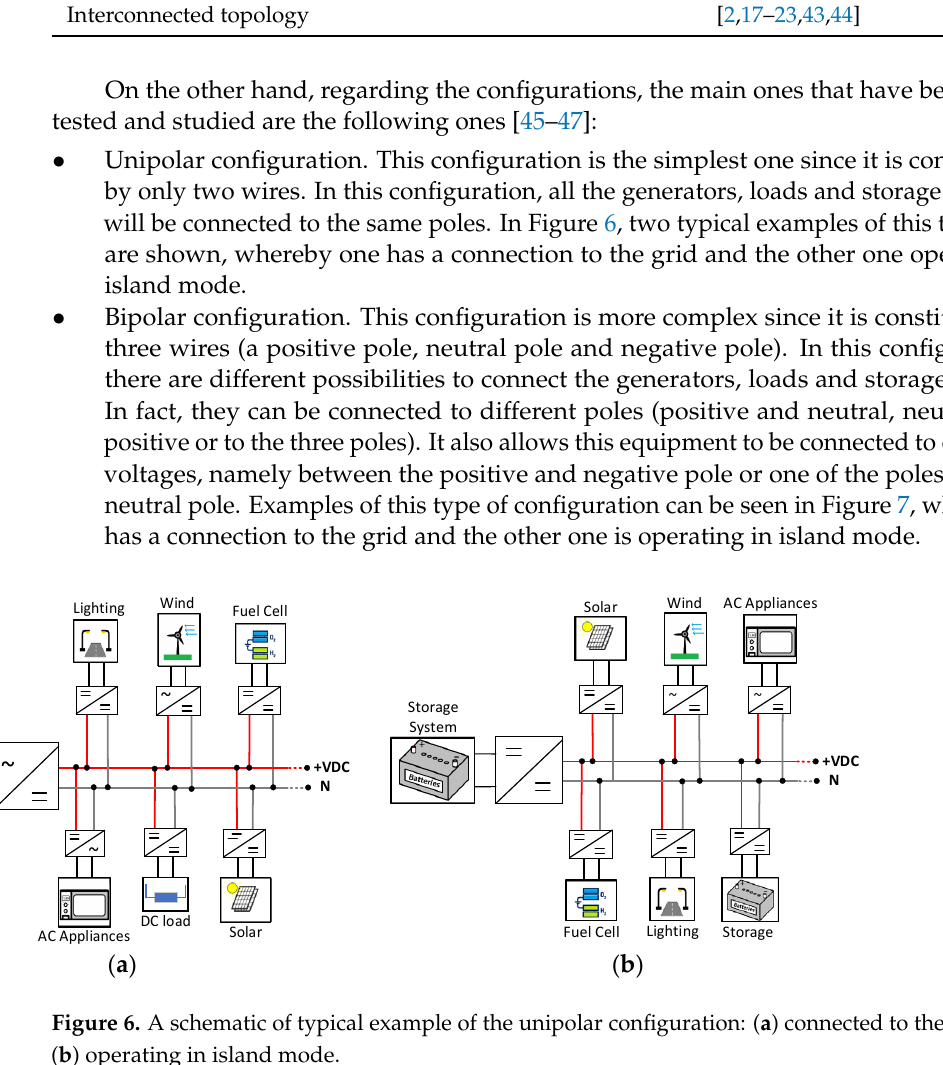
Figure 5. A schematic of typical example of the interconnected topology.